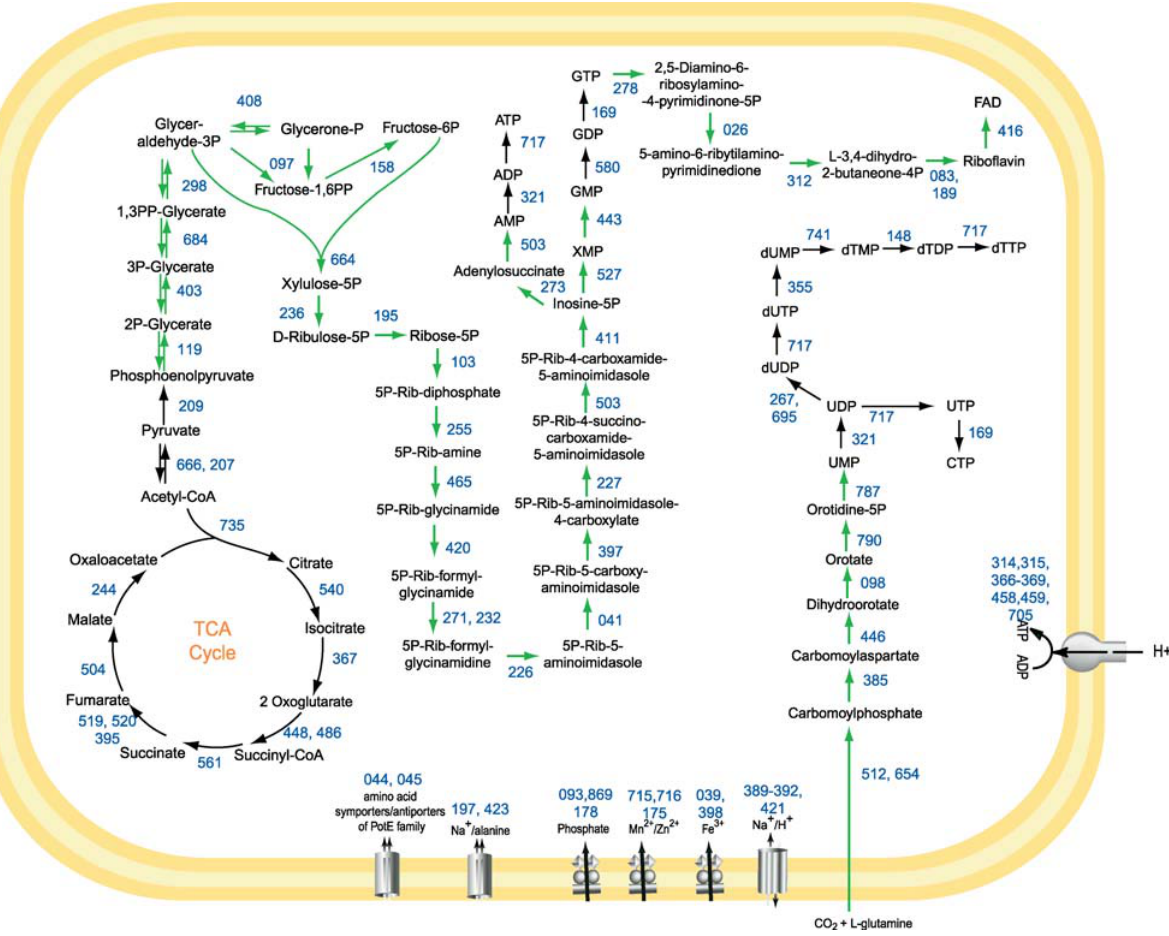
Figure 3. Metabolic Pathways Retained in wBm Pathways shared by Wolbachia and Rickettsia are shown with black arrows. Pathways present in Wolbachia but not in Rickettsia are shown with green arrows. Numbering alongside pathway arrows reflects enzyme annotation, a table of which is available at http://tools.neb.com/wolbachia/. DOI: